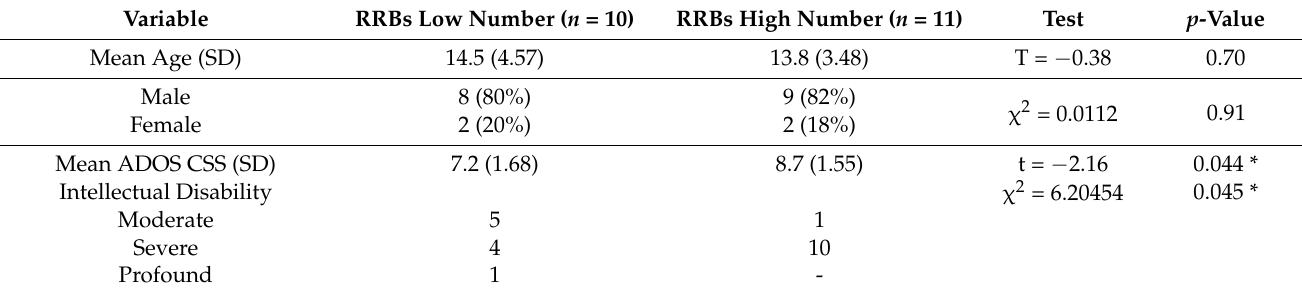
Table 4. Comparison among subjects with a low number (5 or less) and a high number (20 or more) of RRBs. Variable